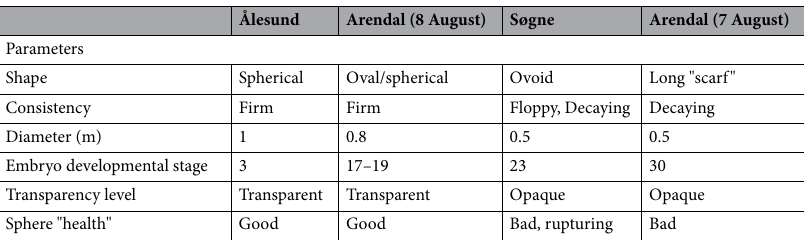
Ålesund Arendal (8 August) Søgne Arendal (7